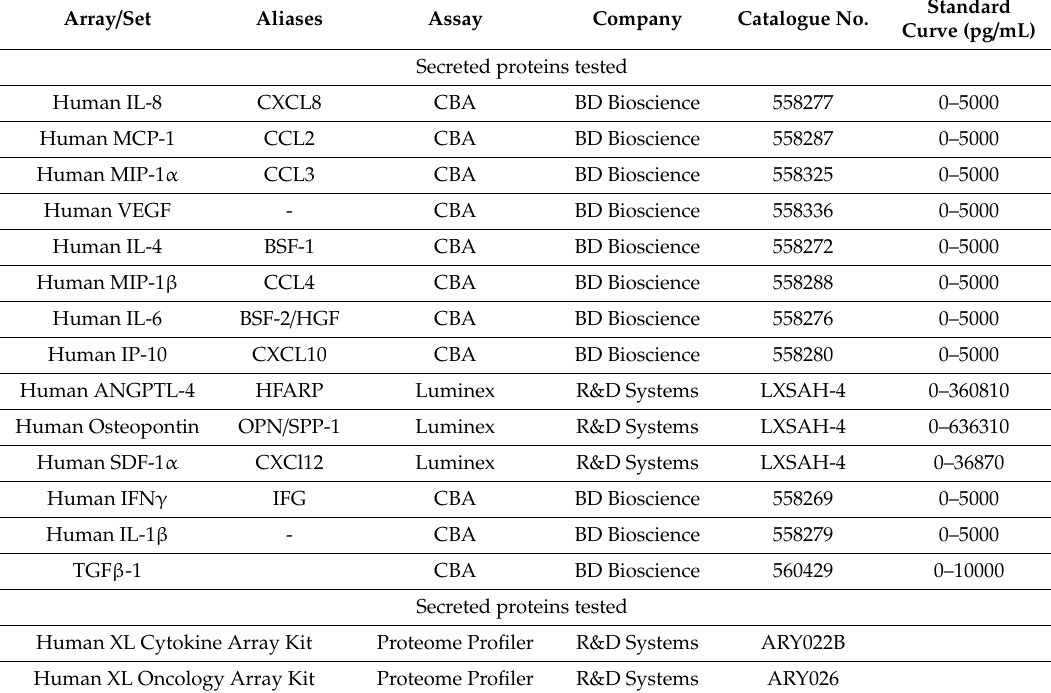
Table A1. Cytokines measured using cytometric bead array (BD Biosciences) and Luminex bead arrays (R&D systems).